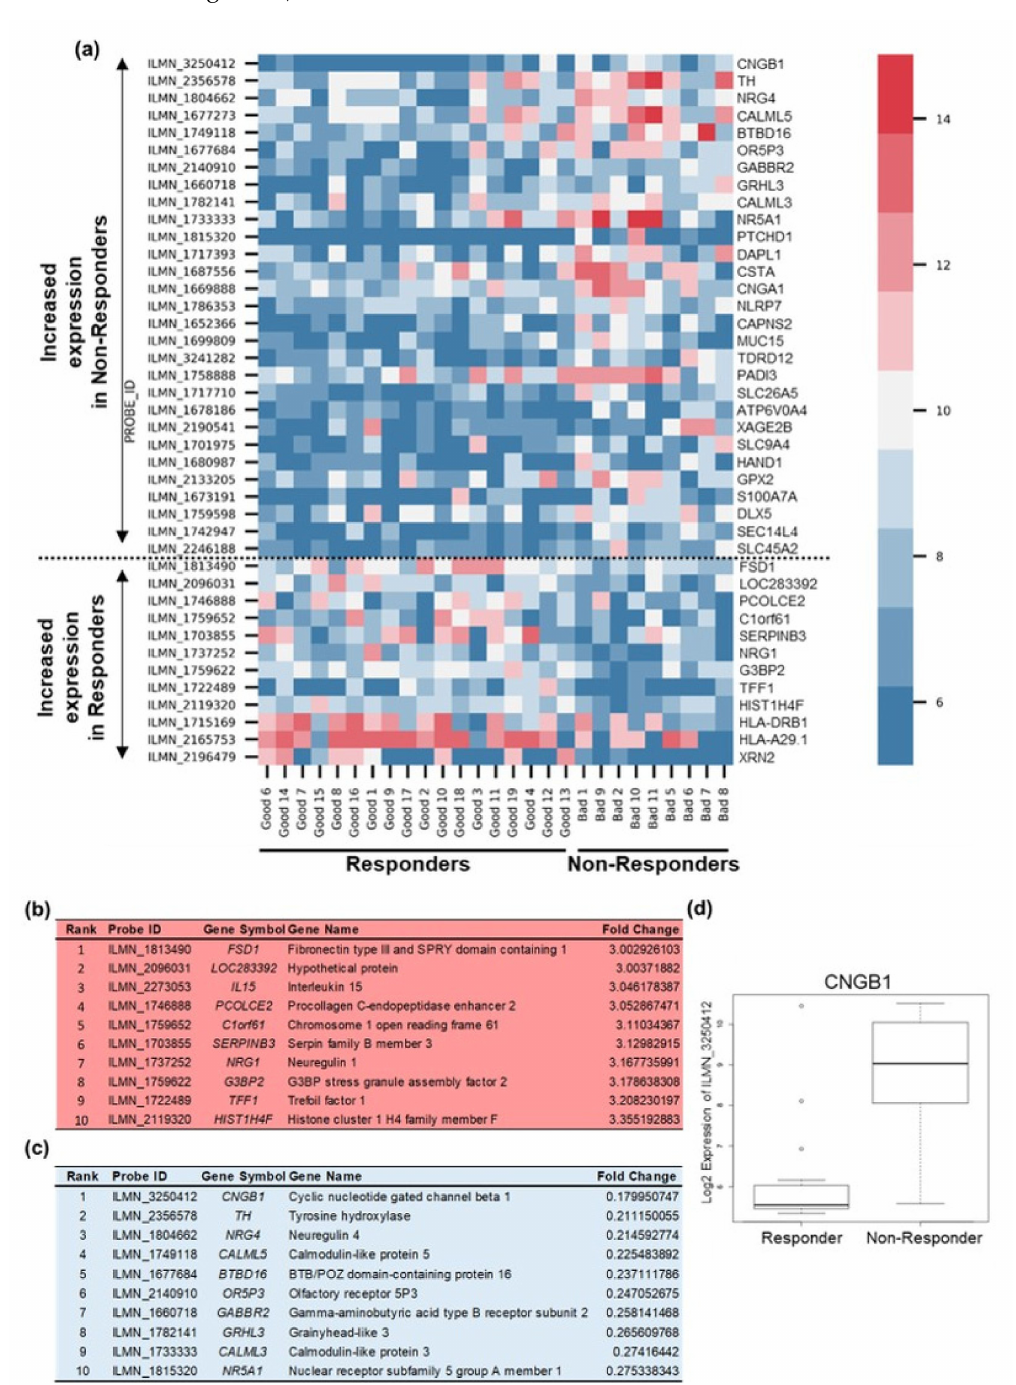
Figure 3. Differential gene expression analysis to corroborate machine learning data. ( a ) Heat map of genes differentially expressed by ‘responders’ and ‘non-responders’ in the Discovery cohort. Rows, single gene; columns, single patient. Each cell in the matrix represents the expression level of a single transcript in a single sample with red indicating upregulation and blue indicating downregulation compared with the median expression for that gene across all samples. ( b ) Top 10 genes upregulated (>3-fold) in ‘Responders’ to NAC. For full list, see Table S1. ( c ) Top 10 genes upregulated in ‘Non-Responders’ to NAC. For full list, see Table S2. ( d ) Box plot demonstrating CNGB1 gene expression was upregulated in ‘Non-Responders’ compared to ‘Responders’ ( p =